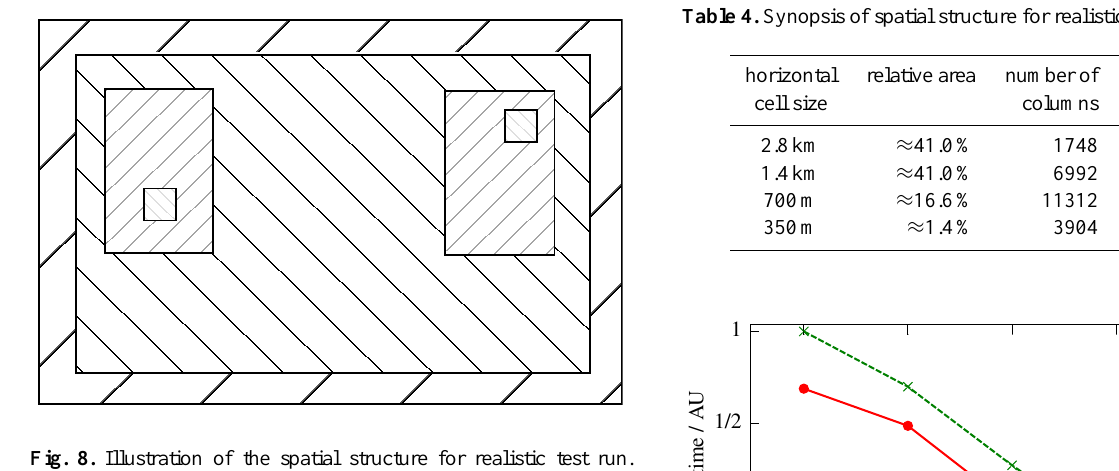
Hatchings correspond to different grid sizes.